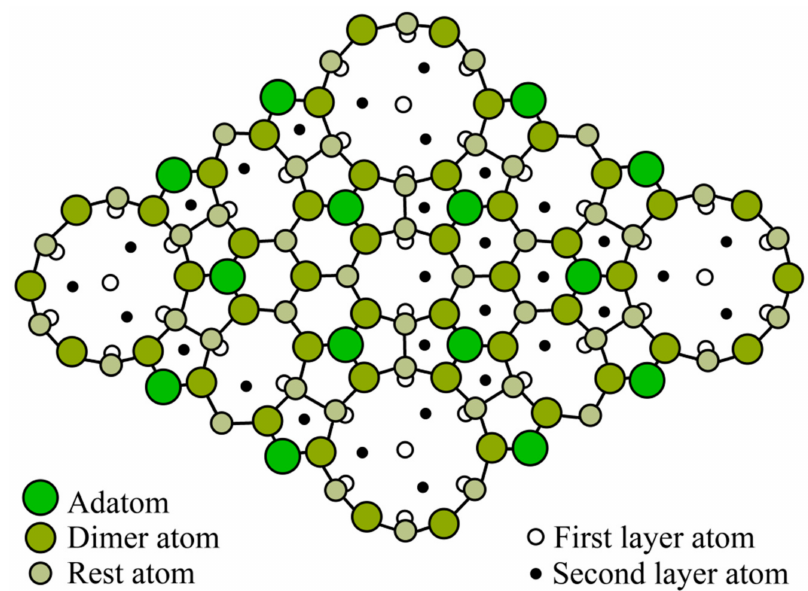
Figure 4. Schematic view of the Ge on Si(111) surface with the 5 × 5 reconstruction.